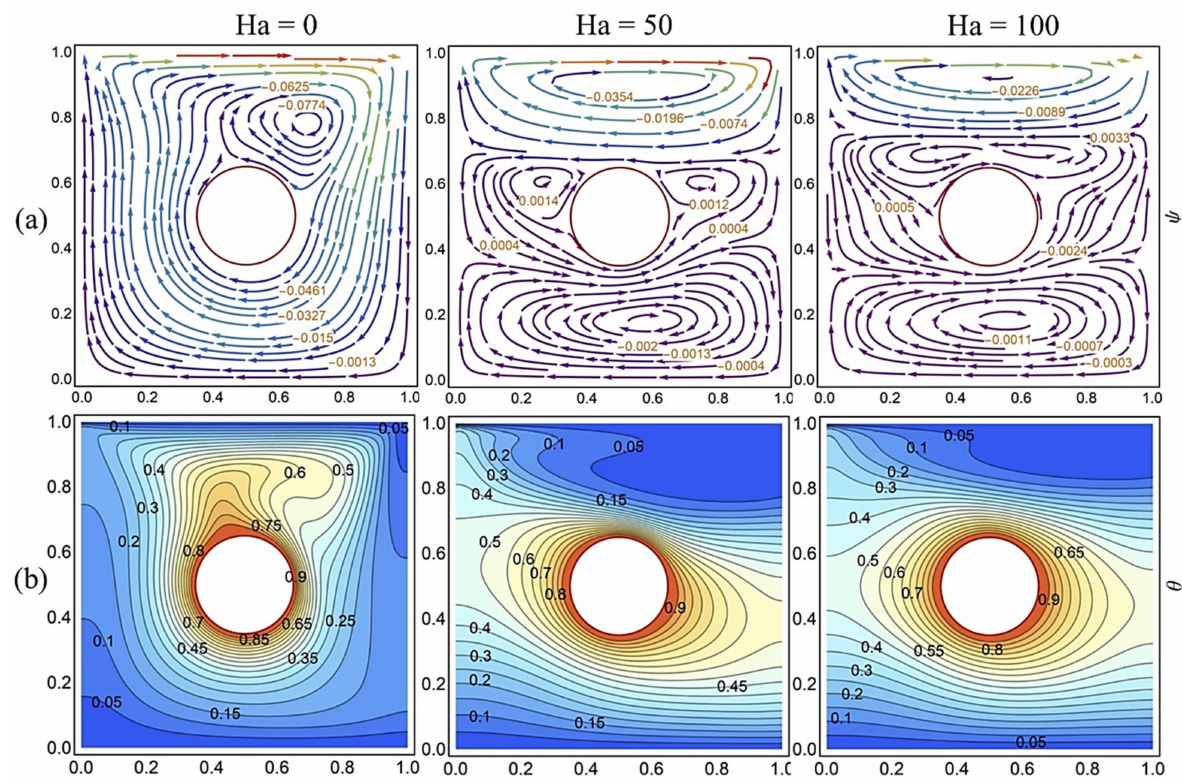
Figure 8. ( a ) Streamlines and ( b ) isotherms at various Ha values while the other parameters φ hnf = 0.02, Ri = 1, α = 45, and β = 0 ◦ are kept